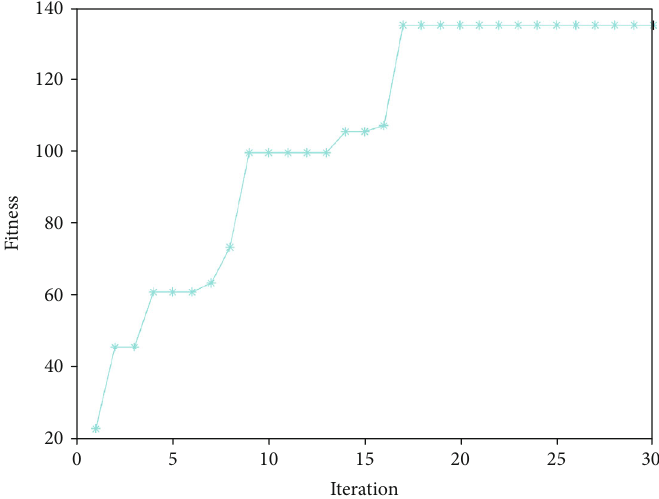
Figure 7: Convergence behaviour of EMTSPA.